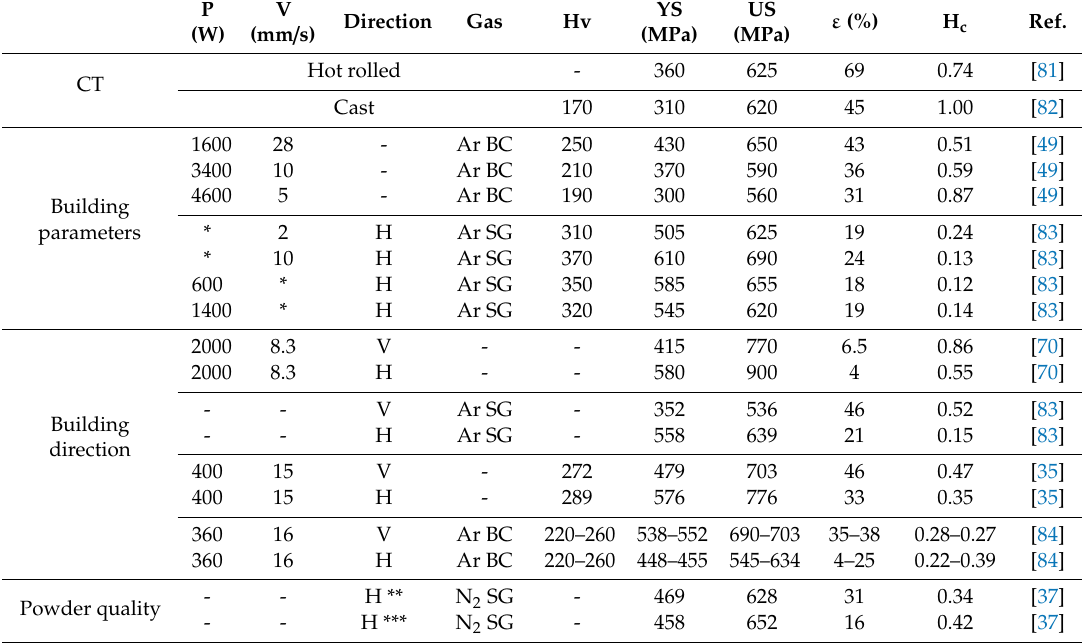
Table 4. A summary of the mechanical properties of AISI 316L samples produced via di ff erent